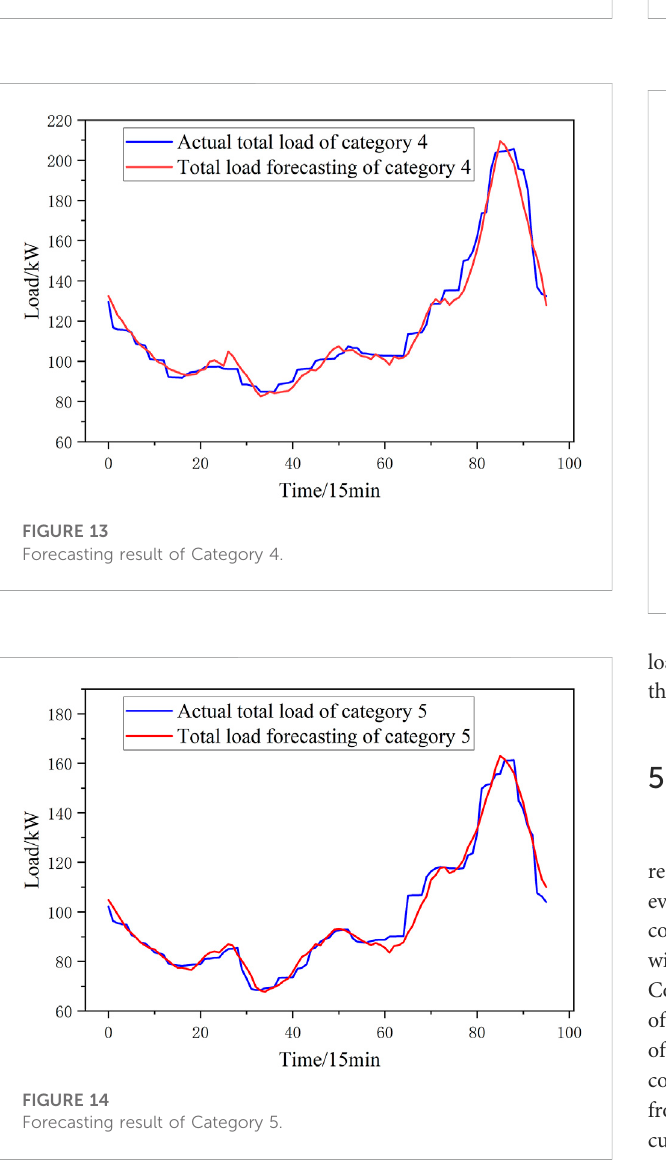
FIGURE 12 Forecasting result of Category 3.